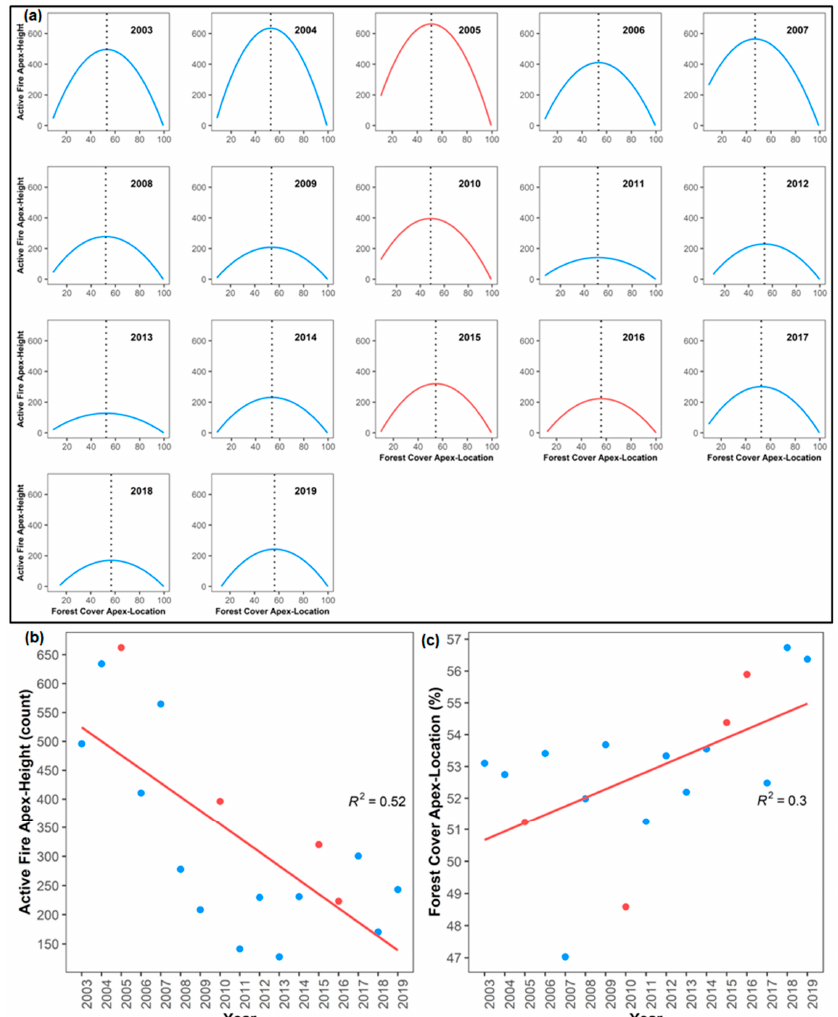
Figure 4. Active fire apex-height and forest cover apex-location behaviour during the analysed years. ( a ) Yearly quadratic models of active fire apex-height and forest cover apex-location relationship. The black dotted lines are the apex of the relationship. Normal climatic years are illustrated with blue plots, and severe dry years are with red plots. ( b ) Active fire apex-height value by year. The red dots are the severe dry years. ( c ) Forest Cover apex-location value by year. The red dots are the severe dry years.